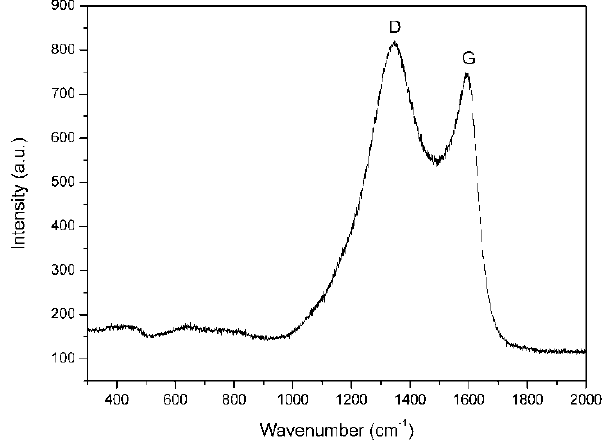
Figure 1. Raman spectrum of Raney Ni/C catalyst.